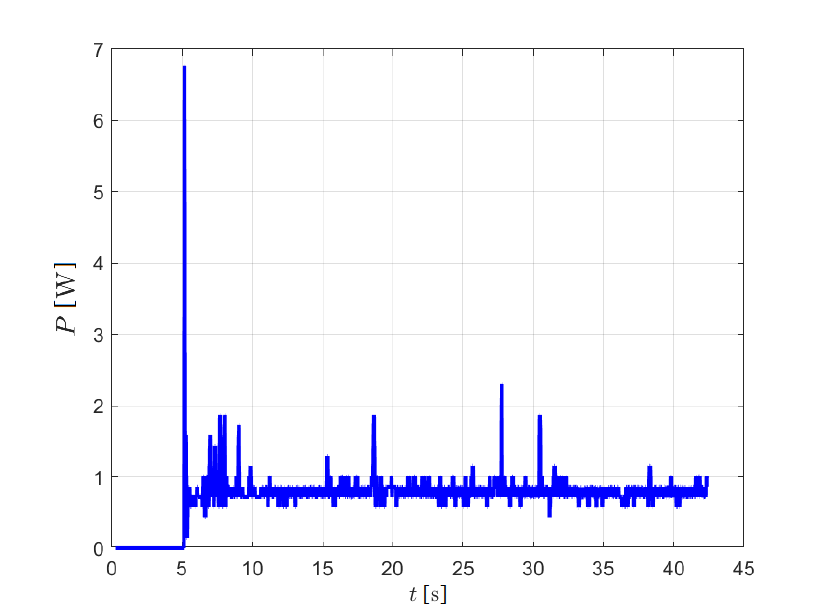
Figure 39. Power P during Map 2 run for the RRT algorithm of the robot.